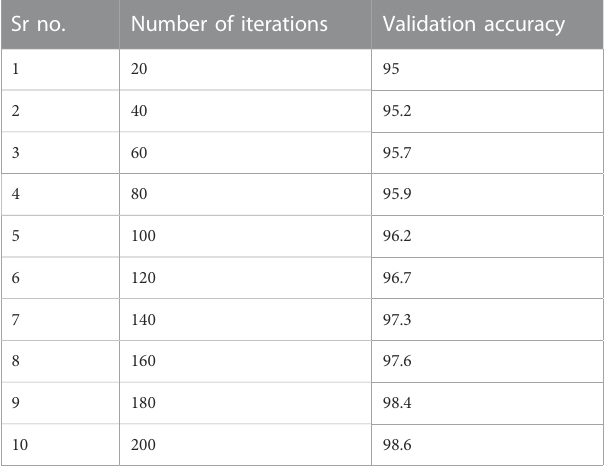
TABLE 4 Comparative study of algorithm performance from 45 to 2,207 MHz with a low signal-to-noise ratio (17 dBm – 5 dBm) [9]. Sr